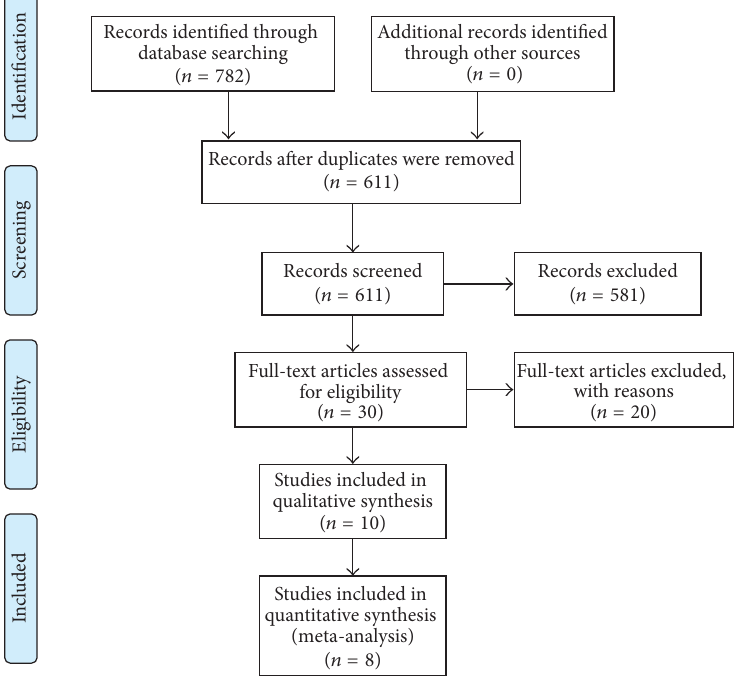
Figure 1: Flow chart of searching strategy for randomized controlled